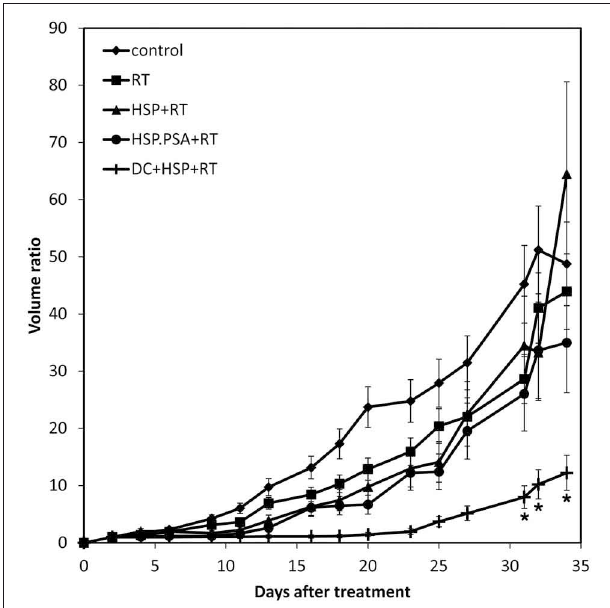
FIGURE 5 | Tumor growth inhibition assay in rHsp70/rPSA without DC. Mice were injected with 1 × 10 5 CT26/PSA tumor cells s.c. on day 0 and treated with 8Gy of RT on day 14 followed by intratumoral injection 50 μ g of rHsp70, or rHsp70C (cid:2) -PSA. Each treatment group included 6 mice. Tumor volume (mm 3 ), with SD for each group, is plotted vs. days after tumor-cell inoculation. ∗ Indicates p < 0 .